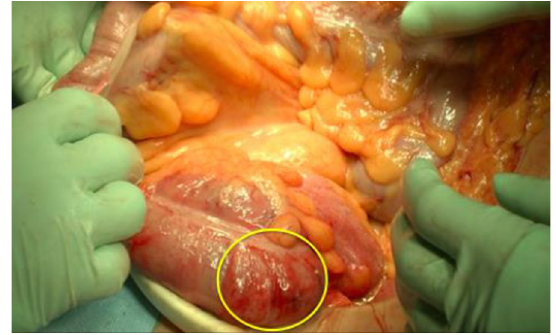
Fig. 2 Intraoperative findings. The cecum shows partial discoloration (circle)